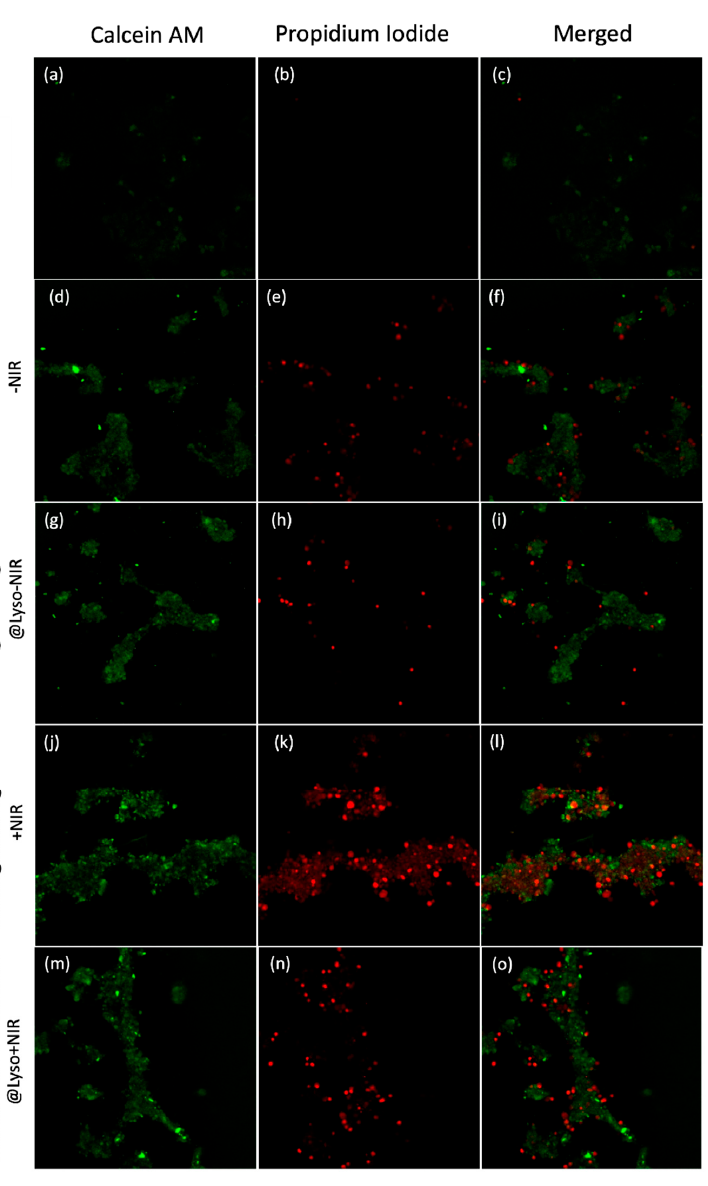
Figure 3. Laser scanning confocal microscopy images showing viability of MCF-7 cells after DOX release from newly developed DRS. DOX release was induced under near-infrared irradiation (NIR-I) using 980 nm lasers. Representative images of cells exposed to the DRS: ( a – c ) without the incorporated drug (DOX) under NIR-I, ( d – f ) containing the UCNPs@cAMS-6@DOX&MS or ( g – i )